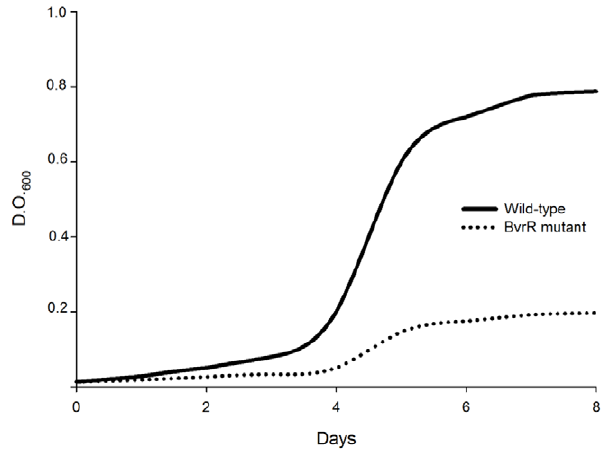
Figure 3. Growth curves of the parental B.abortus 2308 and the bvrR mutant in synthetic minimal media.